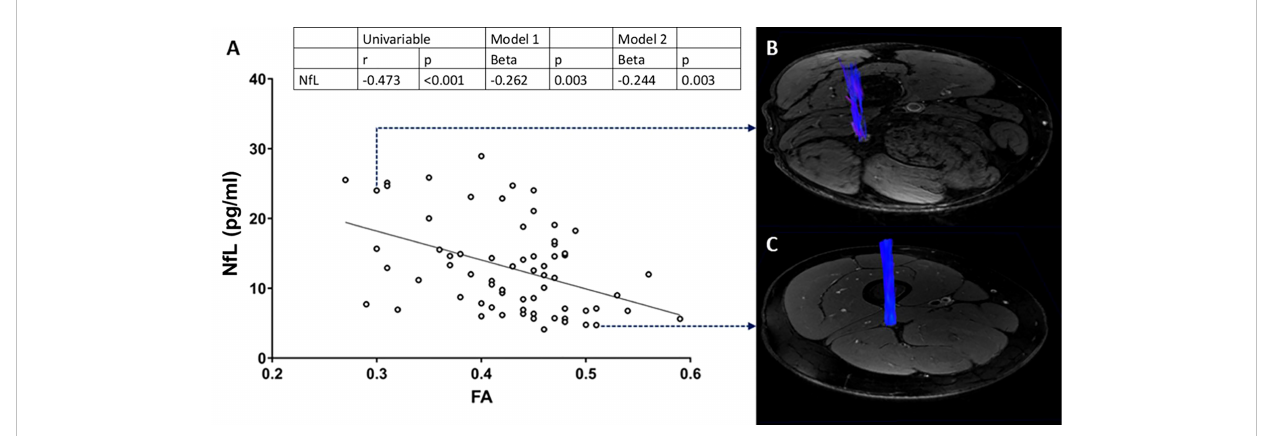
FIGURE 2 Correlation analysis of FA on the sciatic nerve with plasma NfL (A) . Reconstructed, 3D fi ber track of the right sciatic nerve of a patient with decreased FA and increased NfL (B) , and a heathy control (C) . FA, fractional anisotropy; NfL, neuro fi lament light chain protein.